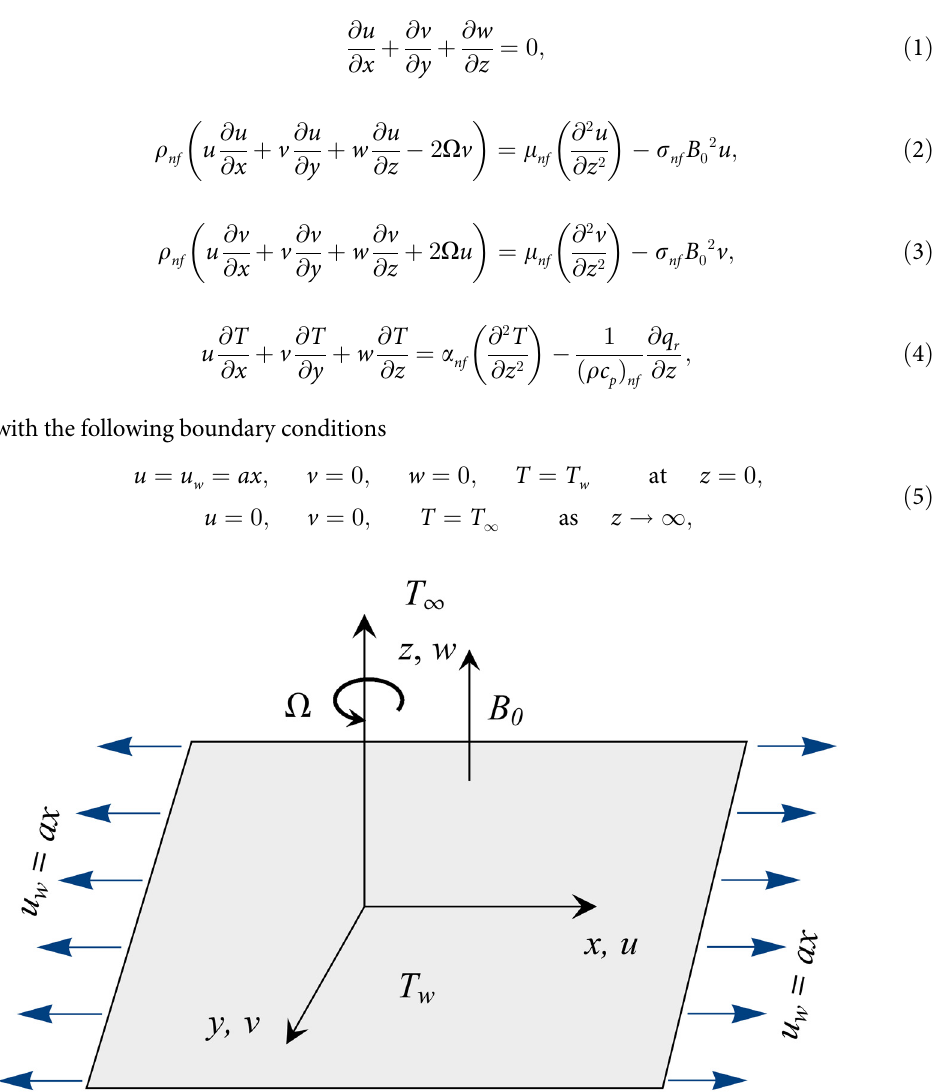
Fig 1. Geometry of the problem and coordinate